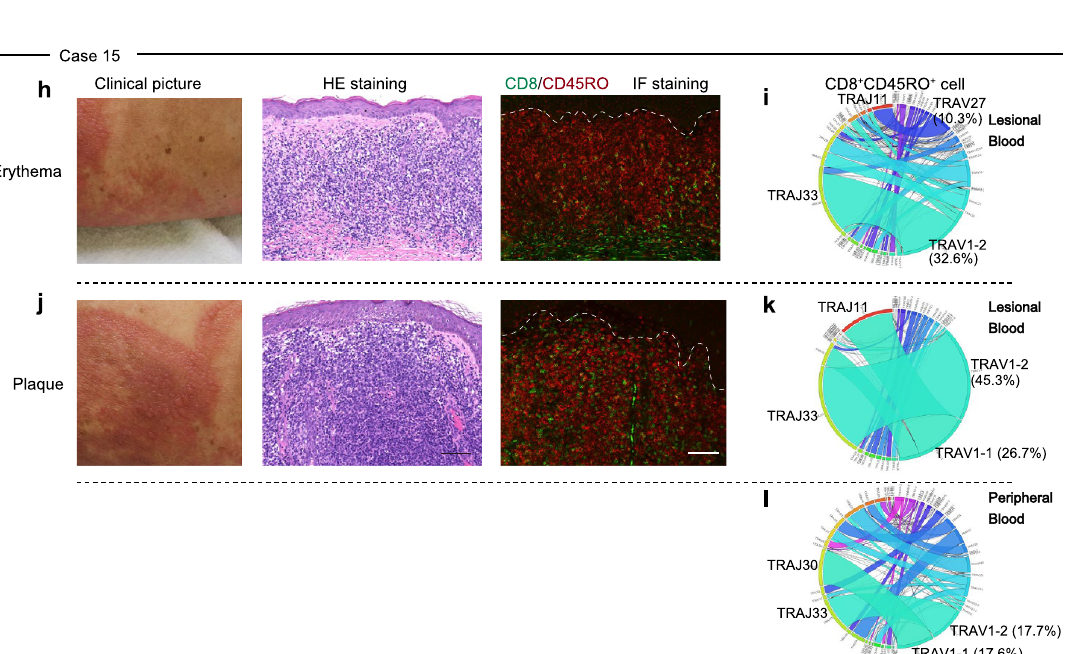
Figure 4. CD8 + CD45RO + TCR repertoire differs depending on the stage of MF. ( a,c,e ) Hematoxylin and eosin (HE) staining and immunofluorescence (IF) staining of 3 types of skin lesions (erythema, plaque, and tumor) from Case 10. CD8 (green) and CD45RO (red) are shown in the immunofluorescence staining image. Collagen is stained green, and red blood cells are stained red. Scale bar = 100 μm. ( b,d,f,g ) Circos plots of frequencies of Vα and Jα gene usage and combinations for CD8 + CD45RO + T cells in lesional blood from erythema, plaque, and tumor stages. The Circos plot at the bottom ( g ) is of cells obtained from peripheral blood. ( h–l ) Erythema and plaque of the same skin lesion from case 15. Same experiment as shown in panels ( a–g